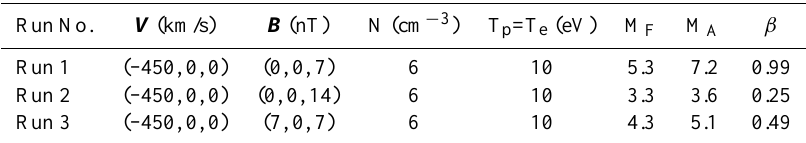
Fig. 7. Four more realistic possible patterns between the slow mode wave group velocity and the flow velocity. The background magnetic field is in the upward direction in all these panels. Only partial slow mode wave group velocity is shown in each panel for simplicity. In pattern 1, the slow mode wave group velocity can overcome the flow velocity, thus the slow mode waves can propagate upstream along the flow line. In patterns 3 and 4, the slow mode wave group velocity cannot overcome the flow velocity, thus the slow mode waves are taken downstream by the flow. Pattern 2 is between pattern 1 and patterns 3 and 4, where the flow velocity and the slow mode wave group velocity cancel each other in the flow direction. The slow mode front occurs where pattern 2 exists. Table 1. Input solar wind plasma and IMF parameters in the GSE coordinate for the global model runs in this study. Here M F is the fast mode Mach number and M A is the Alfv´en Mach number. Run